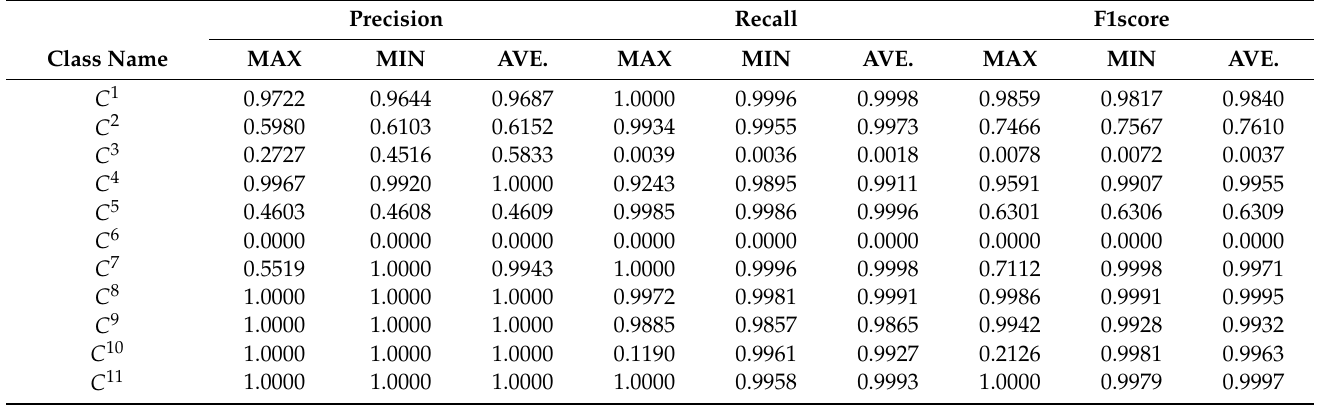
Table 14. Performance analysis for N-BaIoT with GNB and MI feature selection on the test dataset.